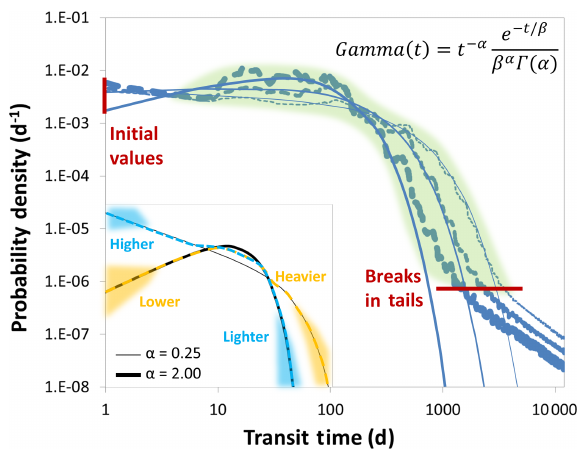
Figure 16. Gamma distributions (solid lines) capture the middle part of the modeled TTDs (dashed lines; thickness corresponds to P sub amount) quite well but do not correctly represent the initial parts, breaks in the tails and heavier tails. Inset: gamma distributions (thick and thin black solid lines) combine either high initial values with heavier tails or zero initial values with lighter tails while mod- eled TTDs often are best described by high initial values and lighter tails (blue dashed line) or low (albeit nonzero) initial values with heavier tails (yellow dashed